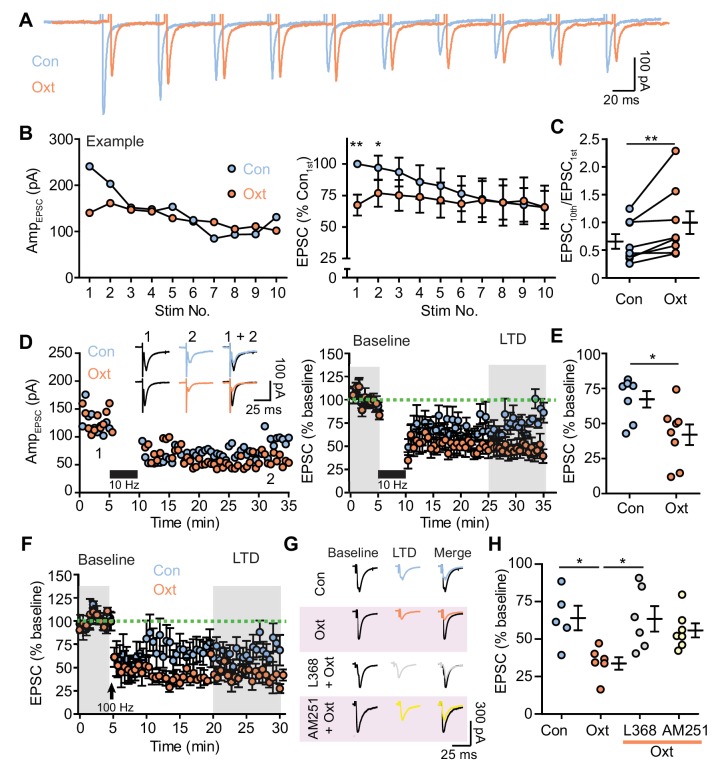
Oxytocin contributes to short and long-term synaptic plasticity of excitatory synaptic transmission.(A) Example voltage-clamp traces from one VTA DA neuron evoked by repetitive electrical stimulation (20 Hz, 10 pulses) in control condition (blue) and during oxytocin application (orange). (B) Left: evoked EPSC amplitudes from the example neuron shown in (A) before and during oxytocin application. Right: summary results of normalized EPSC in control condition and following oxytocin application. EPSC amplitudes were normalized to the amplitude of the first EPSC in the control group. **p<0.001, *p<0.05, Wilcoxon matched-pairs signed rank test, n = 8 neurons from five mice. (C) Oxytocin increases the ratio between the 10th EPSC and the first EPSC within a train of stimuli. **p<0.01, Wilcoxon matched-pairs signed rank test, n = 8 neurons from five mice. (D) Oxytocin application adds to long-term depression (LTD) of EPSCs induced by 5 min, 10 Hz repetitive electrical stimulation (black bars). Left: EPSC amplitudes recorded from two representative neurons in the control condition and in the presence of oxytocin. Inset shows example traces from two neurons before and after LTD induction. Right: summary results show the normalized evoked EPSC amplitude across time in the control condition and in the presence of oxytocin. EPSC amplitudes were normalized based on a 5 min baseline recording (first shaded interval). n = 7 neurons from five mice for controls; eight neurons from six mice in the presence of oxytocin. (E) Summary data showing normalized EPSC amplitude after LTD induction (second shaded interval indicated in (D)). *p<0.05, Mann-Whitney test, n = 7 and 8 neurons for control condition and in the presence of oxytocin. (F) Same as (D), but with LTD induction using 1 s long periods of 100 Hz stimulation, repeated four times with 10 second-long inter-train intervals (indicated by arrows). n = 5 neurons from five mice for controls, and six neurons from six mice for oxytocin condition. (G) Example traces before and after LTD induction in control condition, in the presence of oxytocin, in the presence of L368,899 and oxytocin, and in the presence of AM251 and oxytocin. (H) Summary data showing normalized EPSC amplitude after LTD induction (second shaded interval indicated in (F)) in the control condition, in the presence of oxytocin, in the presence of oxytocin and OxtR antagonist L368, 899, and in the presence of oxytocin and CB1 receptor inverse agonist AM251. *p<0.05, Kruskal-Wallis test with Dunn’s Multiple Comparison post hoc test, n = 5 neurons for control, n = 6 neurons for oxytocin condition and oxytocin and L368, 899 condition, n = 7 neurons for oxytocin and AM251 condition.10.7554/eLife.33892.017Figure 4—source data 1.Summary tables of amplitudes of repetitively evoked EPSCs in response to oxytocin and endocannabinoid-signaling related pharmacological agents.